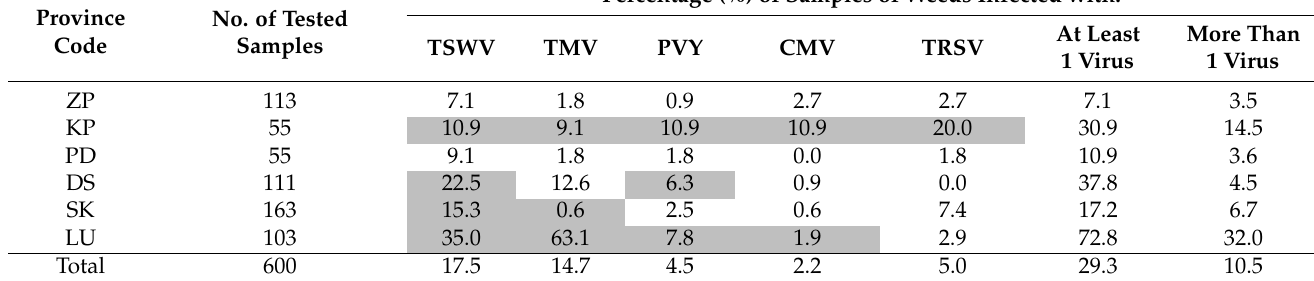
Table 2. Results of DAS-ELISA detection of five viruses in the samples of weeds collected in six provinces in Poland. Shaded cells indicate the detected presence of the same virus in samples of tobacco in the same province. Province